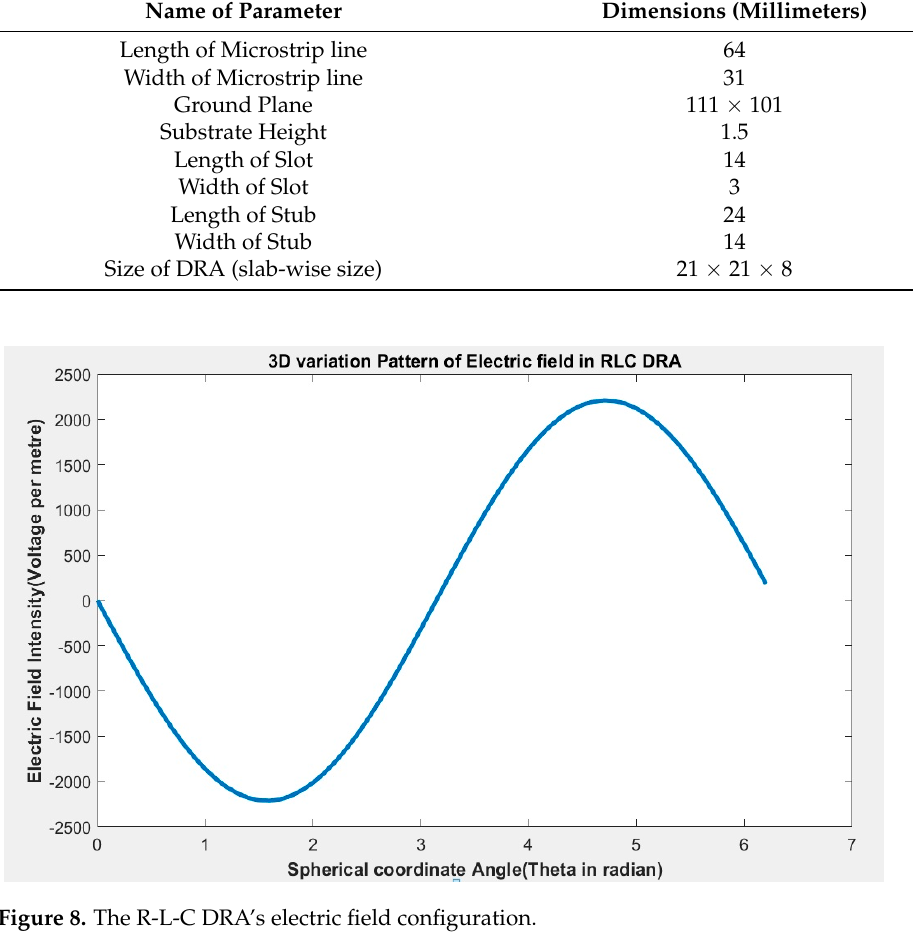
Figure 8. The R-L-C DRA’s electric field configuration.